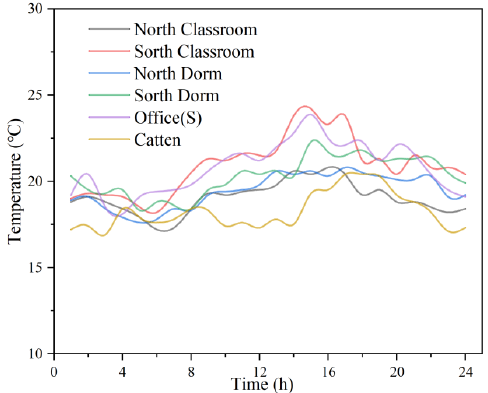
Figure 13. Indoor temperatures in the tested room.